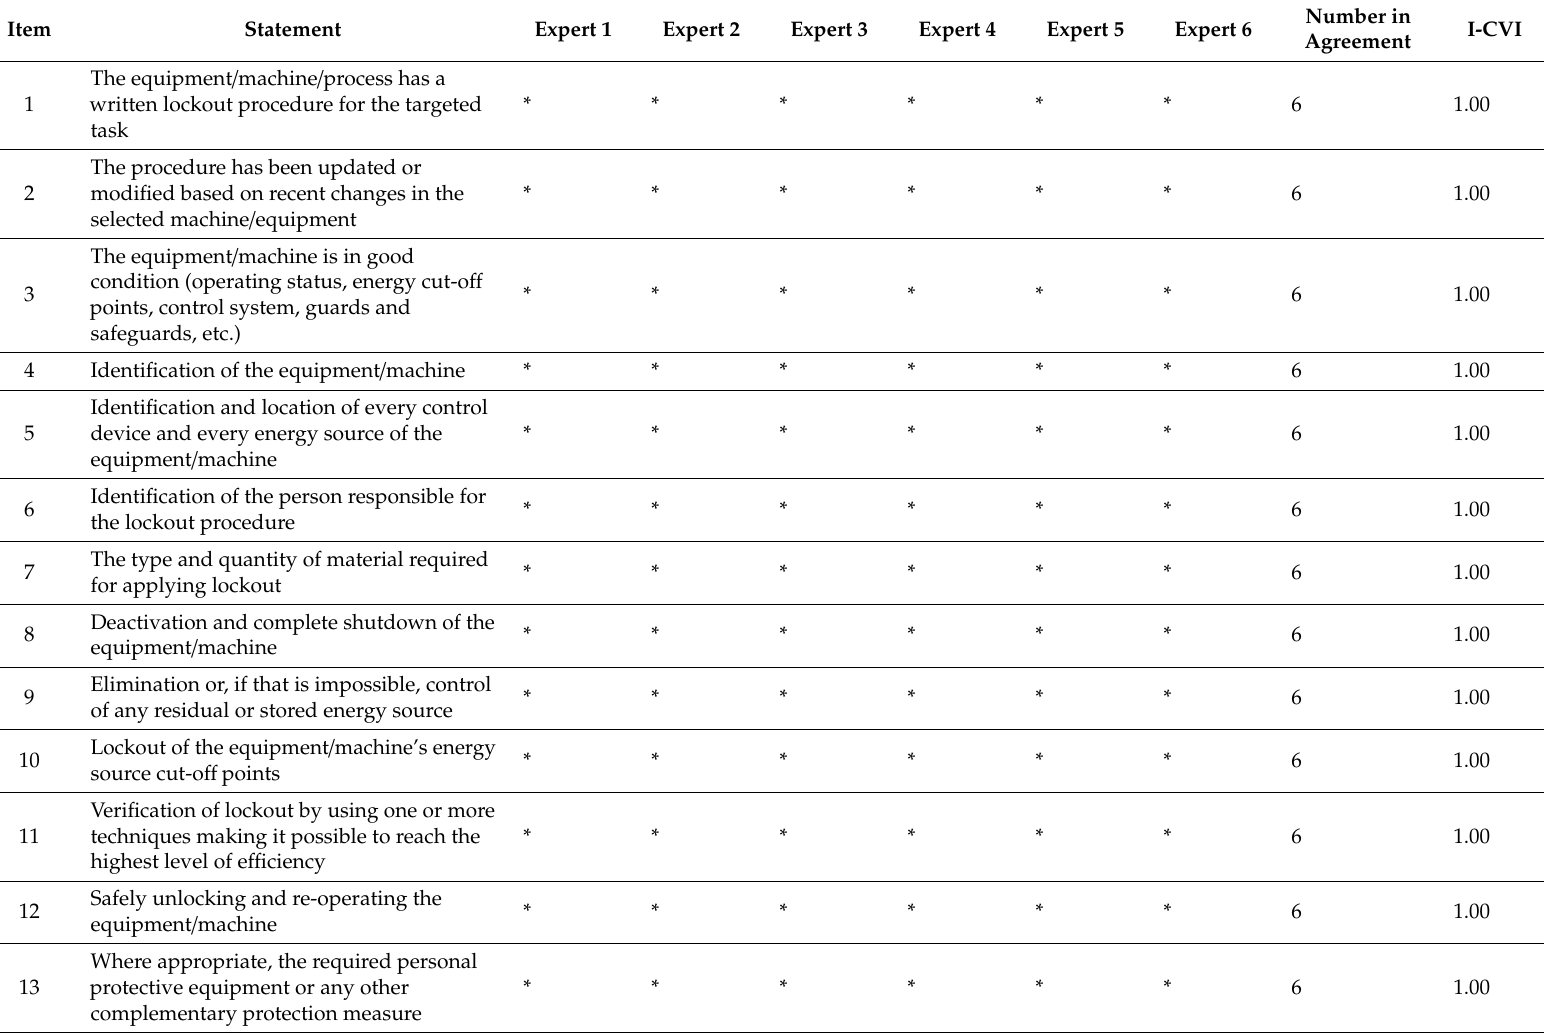
Table A2. Calculation of I-CVI and S-CVI for the initial self-audit tool: Pre-audit of the application of lockout.